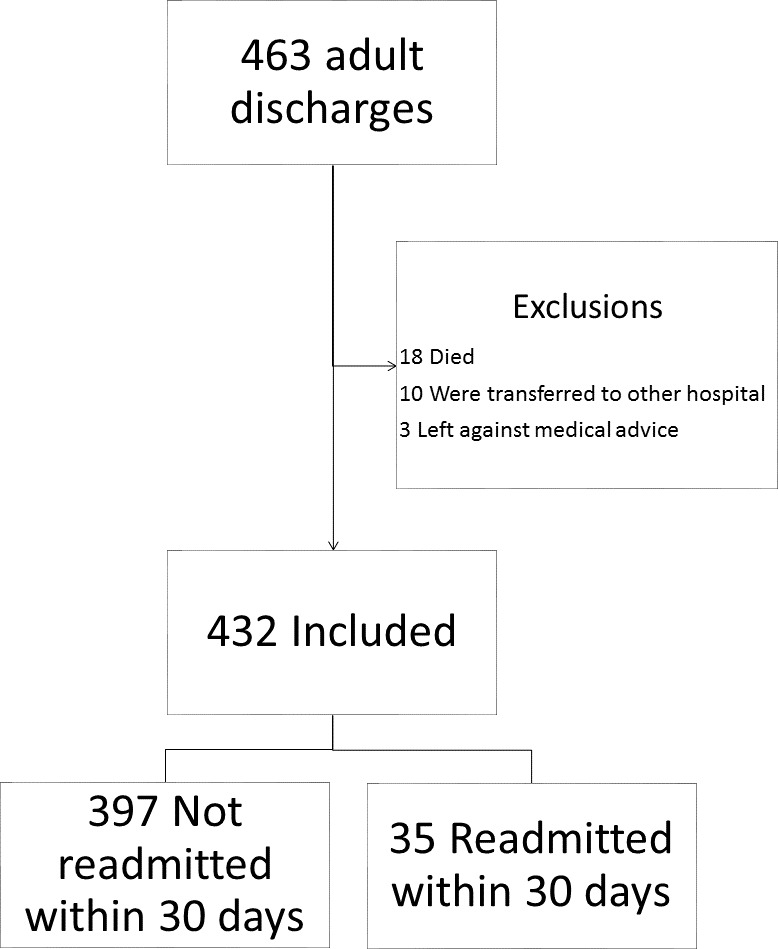
Study flow diagram.